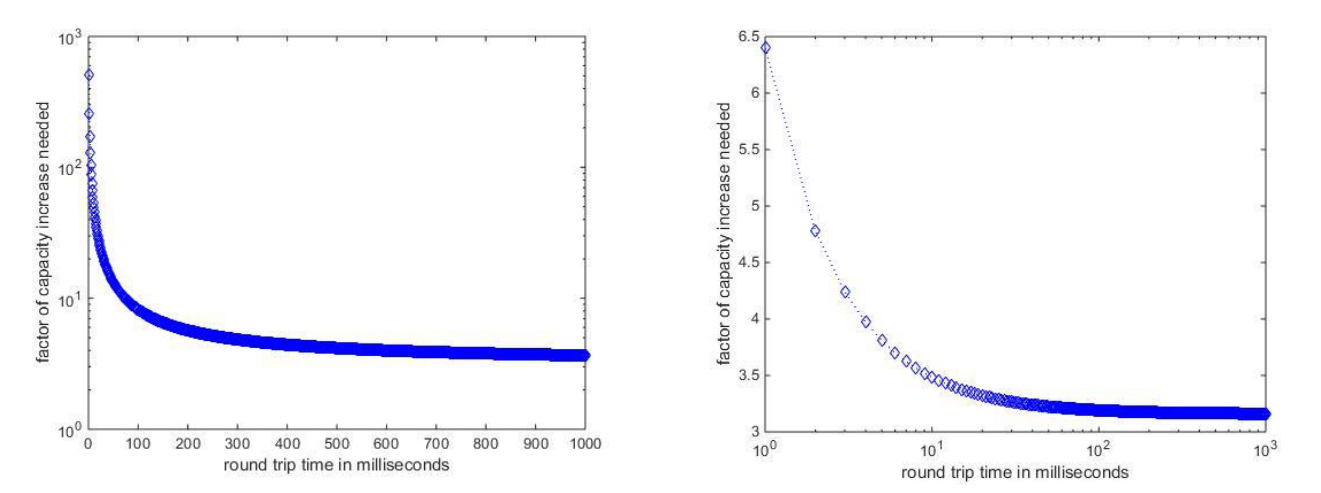
Figure 7. Capacity increase factor for C = 512kbps and